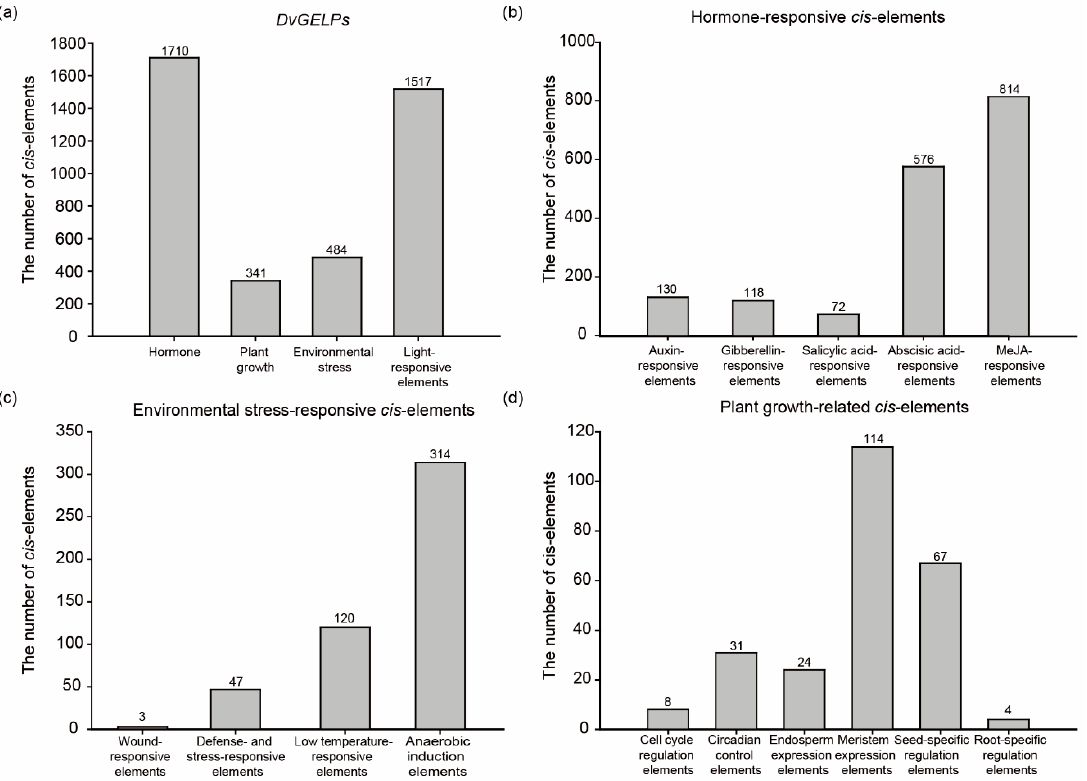
Figure 3. The cis -elements analysis of the DvGELPs promoter sequence. ( a ) The total number of the four types of elements. ( b ) The classification and number of hormone-responsive elements. ( c ) The classification and number of environmental stress-responsive elements. ( d ) The classification and number of plant growth-related elements.